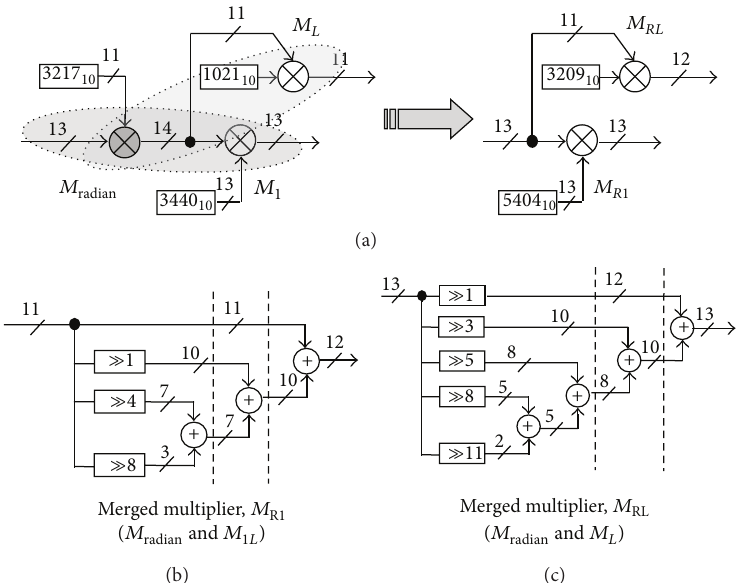
Figure 10: Alternative structures: the merged multipliers. 𝑀 coefficient multiplier, and 𝑀 𝐿 : constant coefficient multiplier of the linear